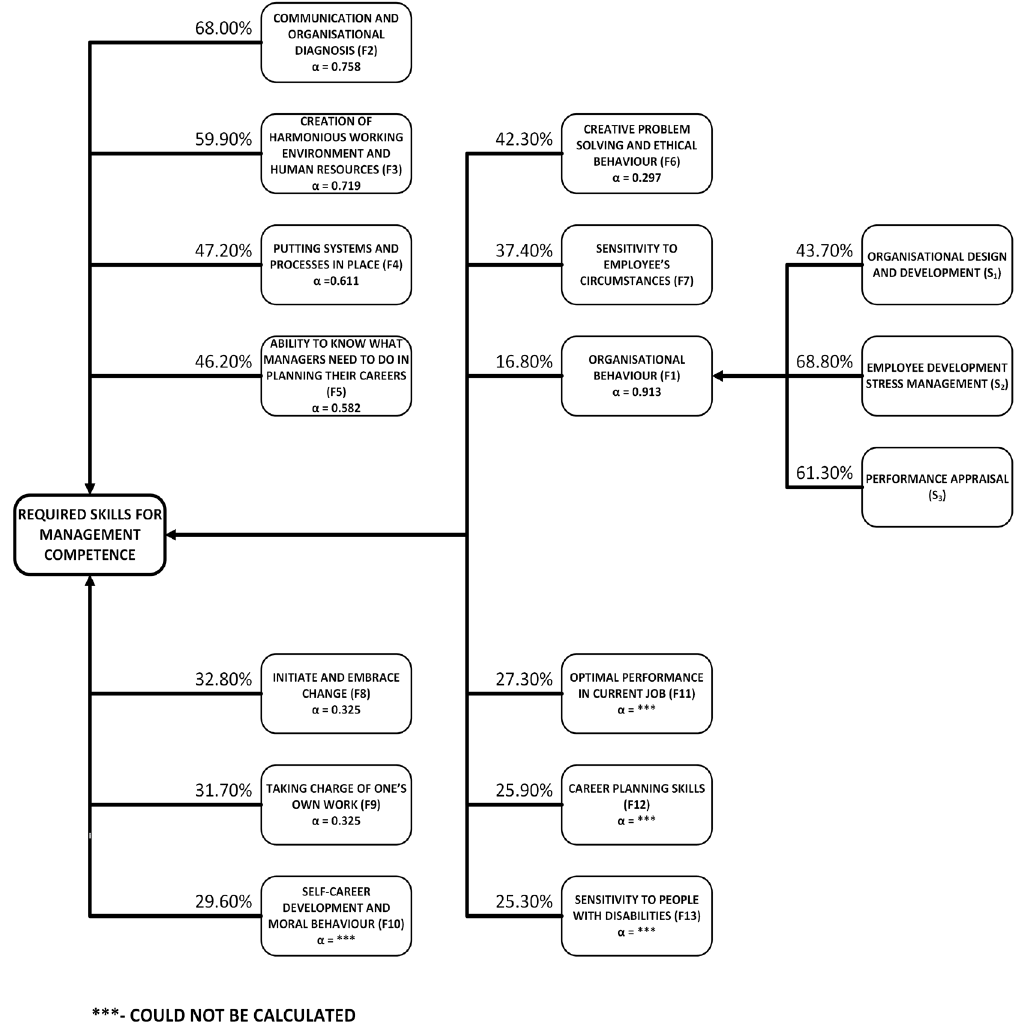
Figure 2. A revised model to measure skills for managerial